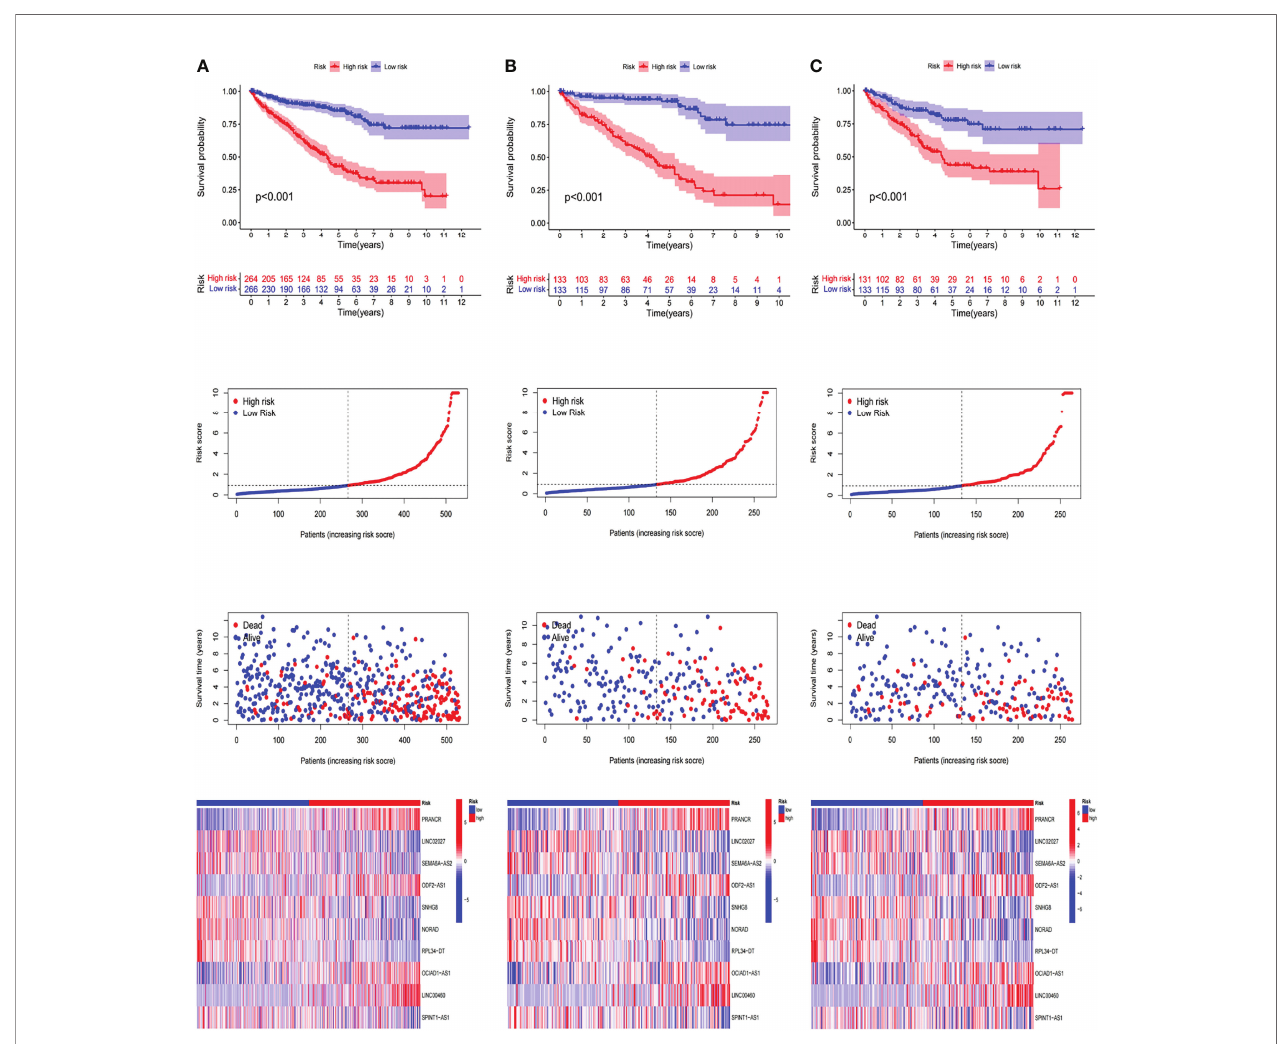
FIGURE 4 | Prognostic value of the risk patterns of the m6A-related lncRNAs model in the TCGA dataset. (A1)Kaplan-Meier survival curves of the OS of patients in the high- and low-risk groups of the entire dataset (A2) Distribution of the m6A-related lncRNAs model-based risk score. (A3) Different patterns of survival status and survival time between both groups. (A4) The expression standards of the m6A-related lncRNAs model for each patient presented by the clustering analysis heatmap. (B, C) Relevant results of the train set and the test